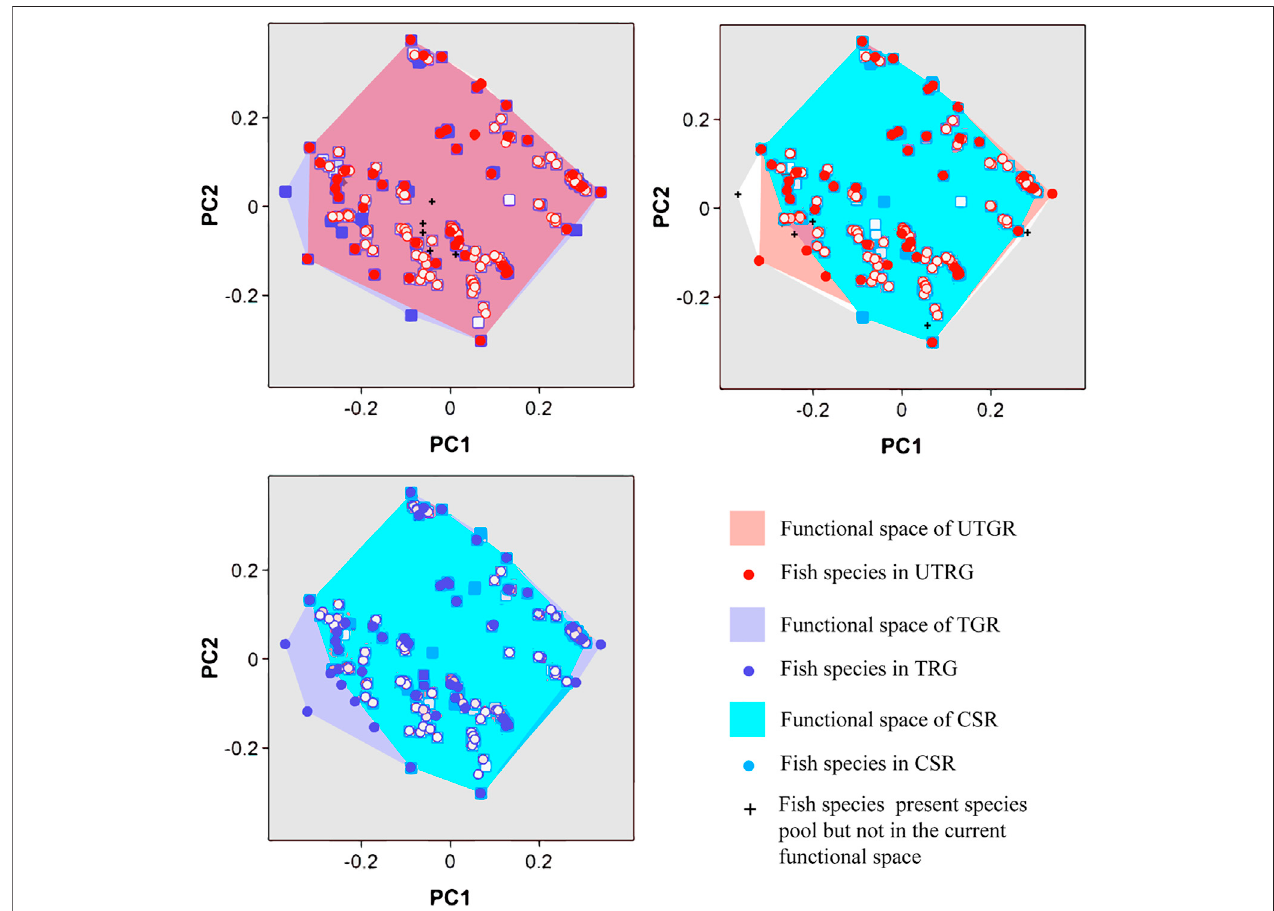
FIGURE 3 | Functional space of fi sh assemblages in the different habitat types in the upper reaches of the Yangtze River.